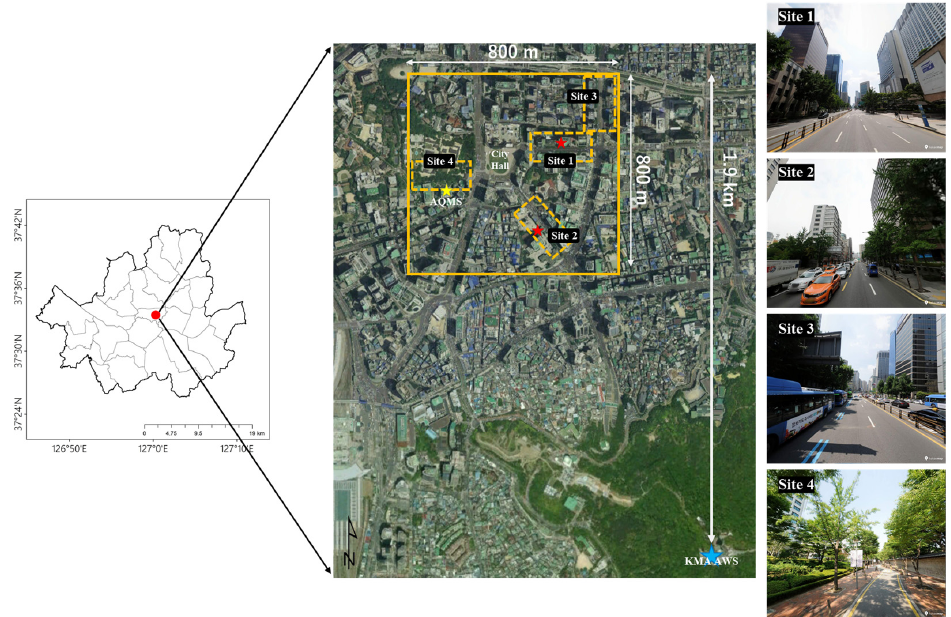
Figure 1. Map of the sensor network monitoring domain. Yellow dashed-lined rectangles represent the micro-environments (sub-sites) where sensor-nodes were installed (4–8 sensor-nodes for each site). Red stars represent the locations of the portable AWS on the ground (Site-1 in summer and Site-2 in winter) and the sky-blue star denotes the location of the AWS operated by the Korea Meteorological Administration (KMA). The yellow circle represents the location of Jung-gu AQMS, operated by the government.